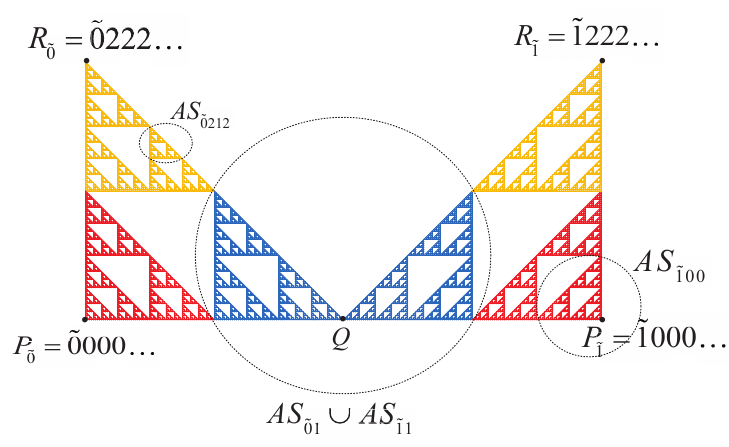
Figure 6. Some code sets and code representations of AS